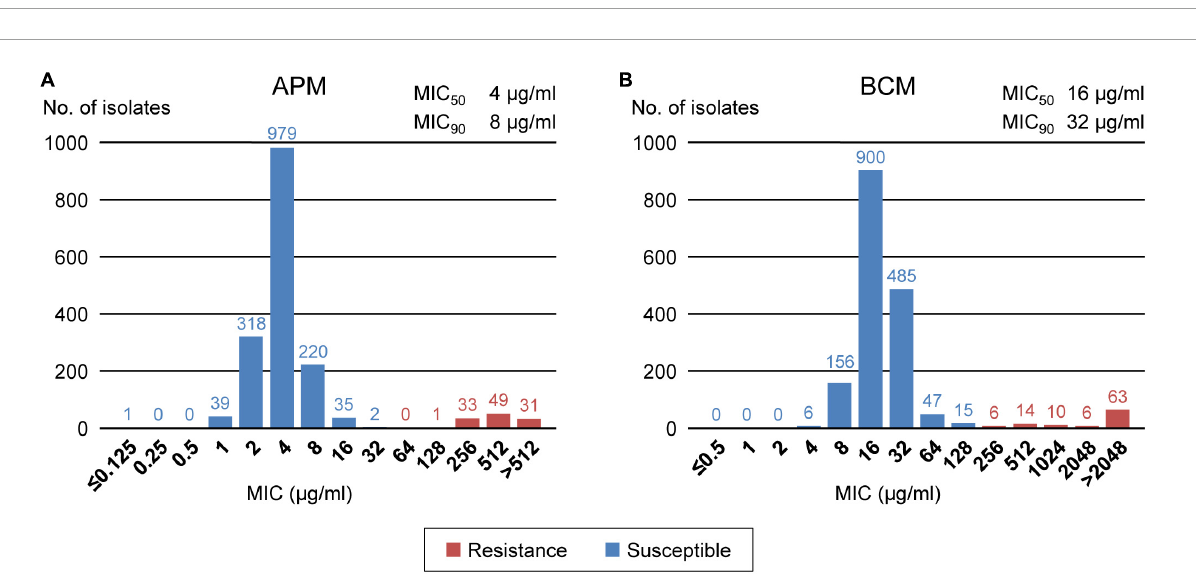
FIGURE4 Distributions of the MICs of apramycin (A) and bicozamycin (B) for the 1,708 E. coli isolates from diseased swine in Japan between 1991 and 2019. The numbers of isolates presenting with each MIC are indicated above the bars. The susceptible and resistant isolates are shown in blue and red, respectively. The MIC50 and MIC90 values are shown at the upper right of each